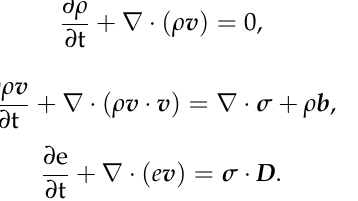
( c ) Figure 3. Structural details of “ Pioneer- I” DSMV. ( a ) DSMV model, ( b ) Track mechanism, ( c ) Track plate model.